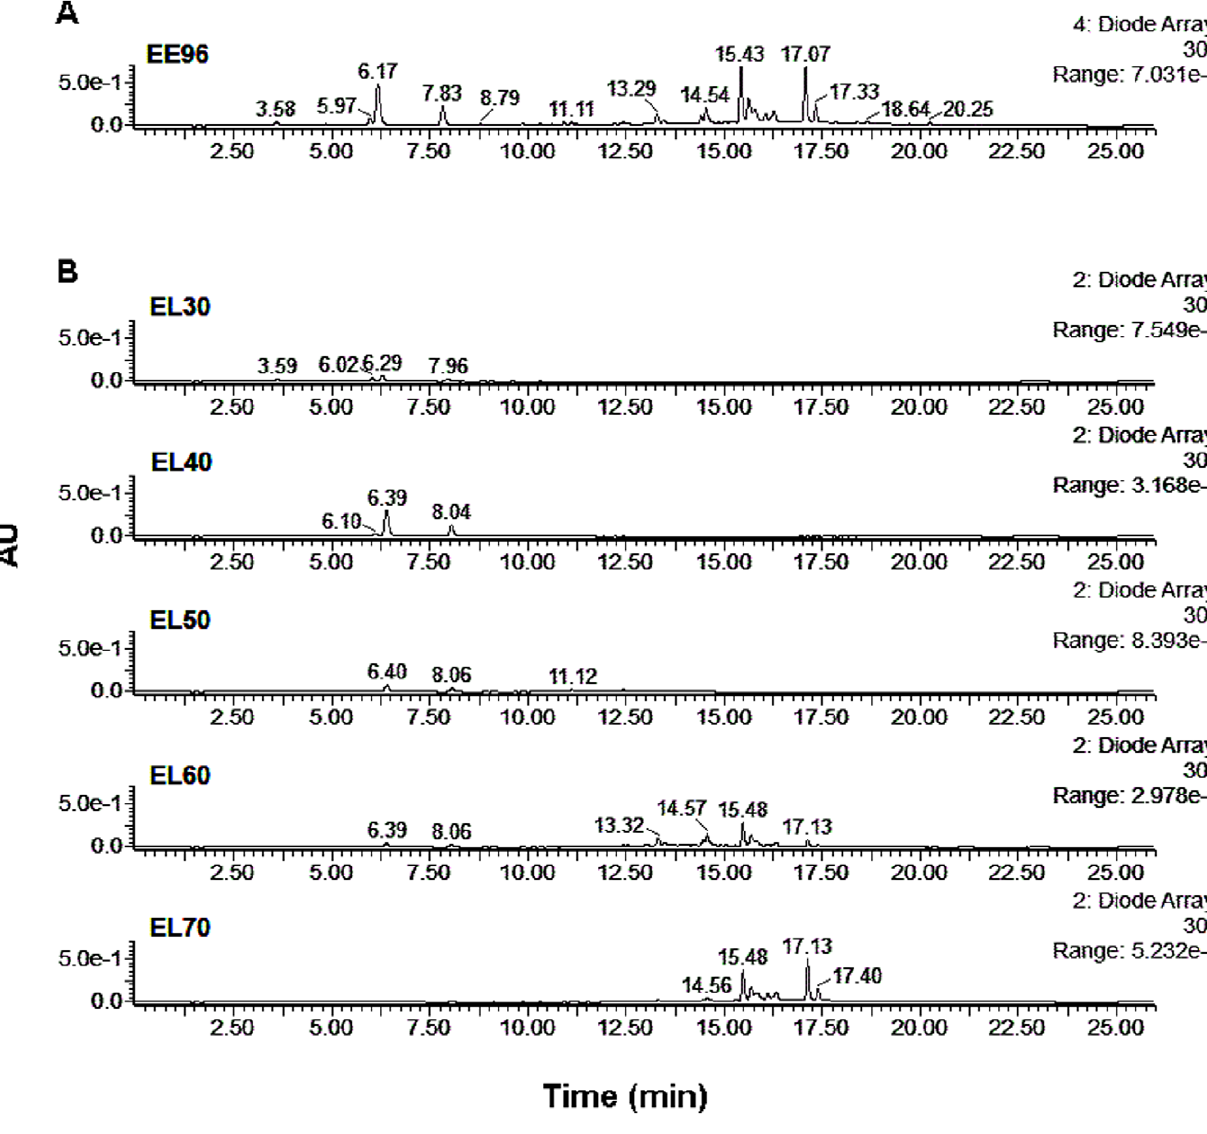
PLOS ONE | www.plosone.org